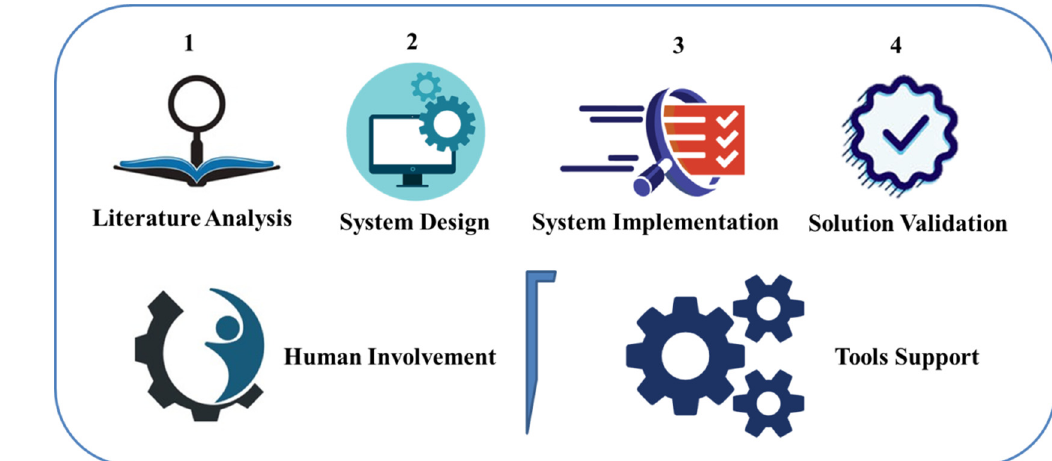
Figure 2. Overview of the research methodology.